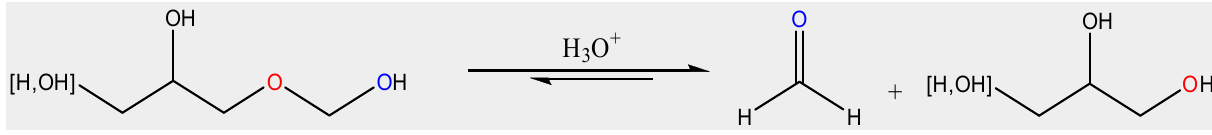
Scheme 2. FA-hemiacetal hydrolysis (colors are used to visualize the distribution of oxygen atoms between the reaction